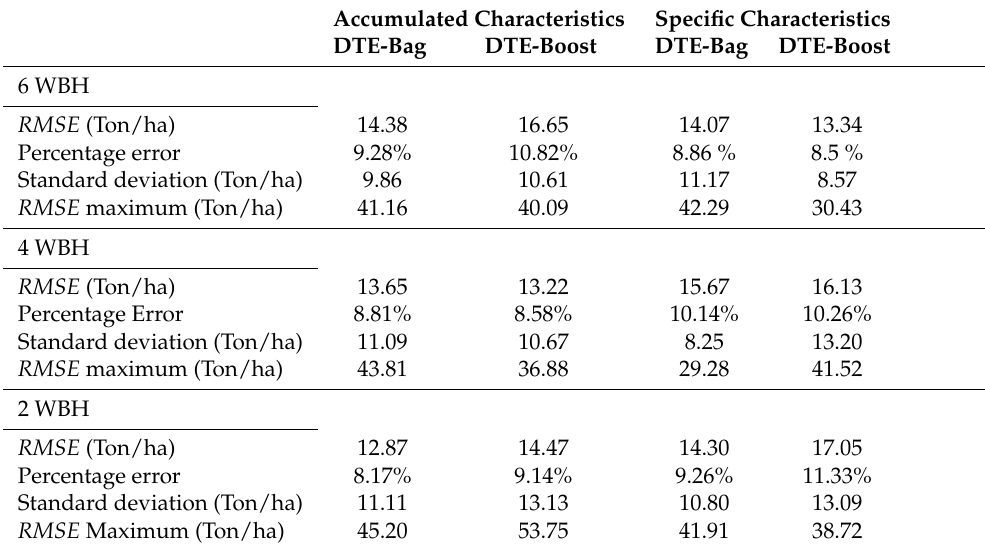
Table 4. Forecasting tomato yield for models generated via DTE-Bag and DTE-Boost for 6, 4, and